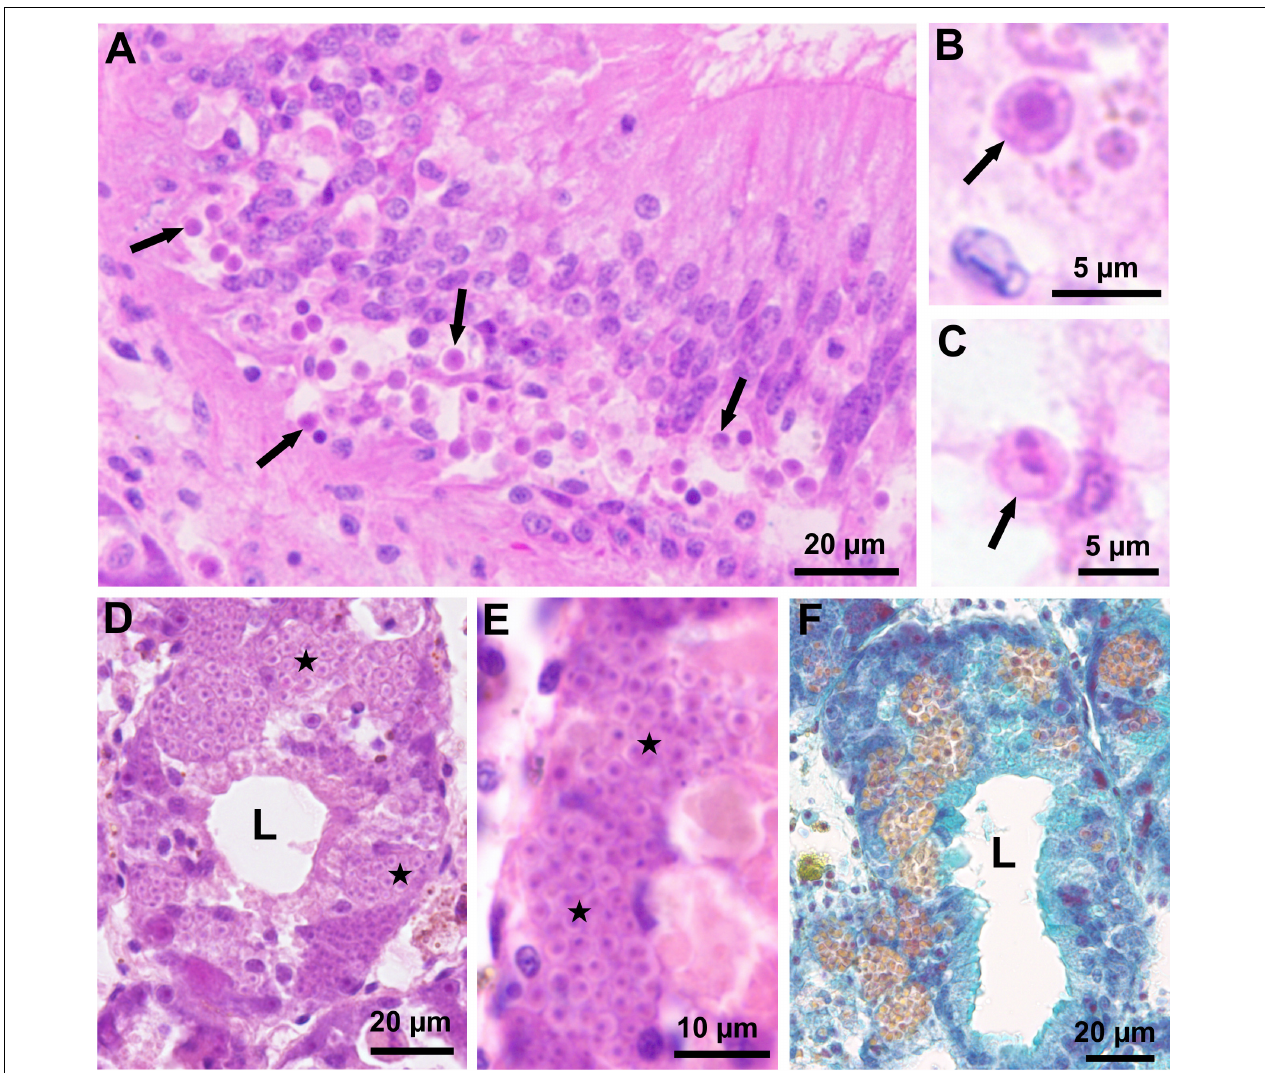
FIGURE 2 | Light micrographs of histological sections through the visceral mass of fan mussels Pinna nobilis infected with Haplosporidium pinnae . (A) Section through the intestine showing numerous uninucleate cells of H. pinnae (arrows) associated with vacuolisation of the host intestinal epithelium (MHE; Lesvos, January 2019). (B) High magnification showing a uninucleate cell of H. pinnae (arrow) in the host connective tissue (MHE; Lesvos, January 2019). (C) High magnification showing a binucleate cell of H. pinnae (arrow) in the host connective tissue (MHE; Lesvos, January 2019). (D) Section through the host digestive gland showing masses of H. pinnae spores (stars) in the epithelium of a digestive tubule (MHE; Majorca, November 2016). (E) High magnification showing masses of H. pinnae spores (stars) in the epithelium of a digestive tubule (MHE; Majorca, November 2016). (F) Section through the host digestive gland, stained with VOF,